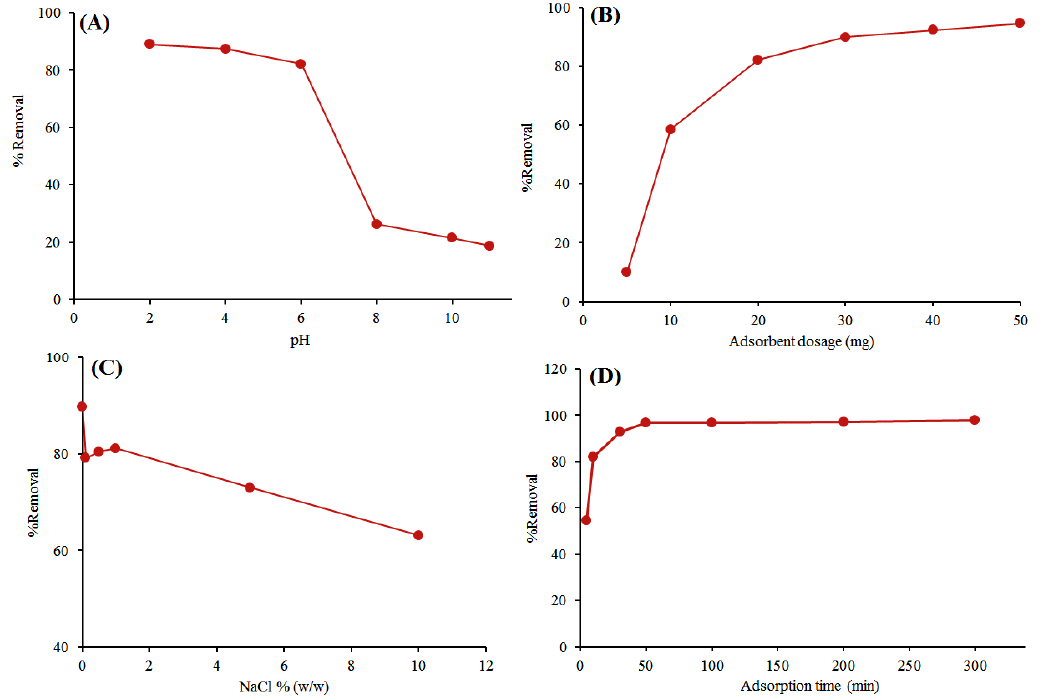
Figure 5. Effect of ( A ) solution pH, ( B ) adsorbent dosage, ( C ) NaCl percentage and ( D ) contact time on cefixime removal efficiency.